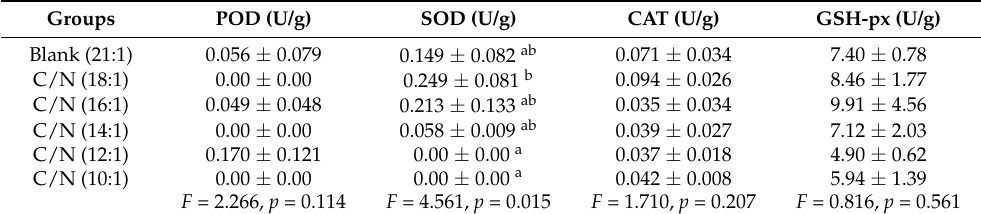
Table 2. Activities of antioxidant enzyme of larvae collected on Day 12 in Trial 2.